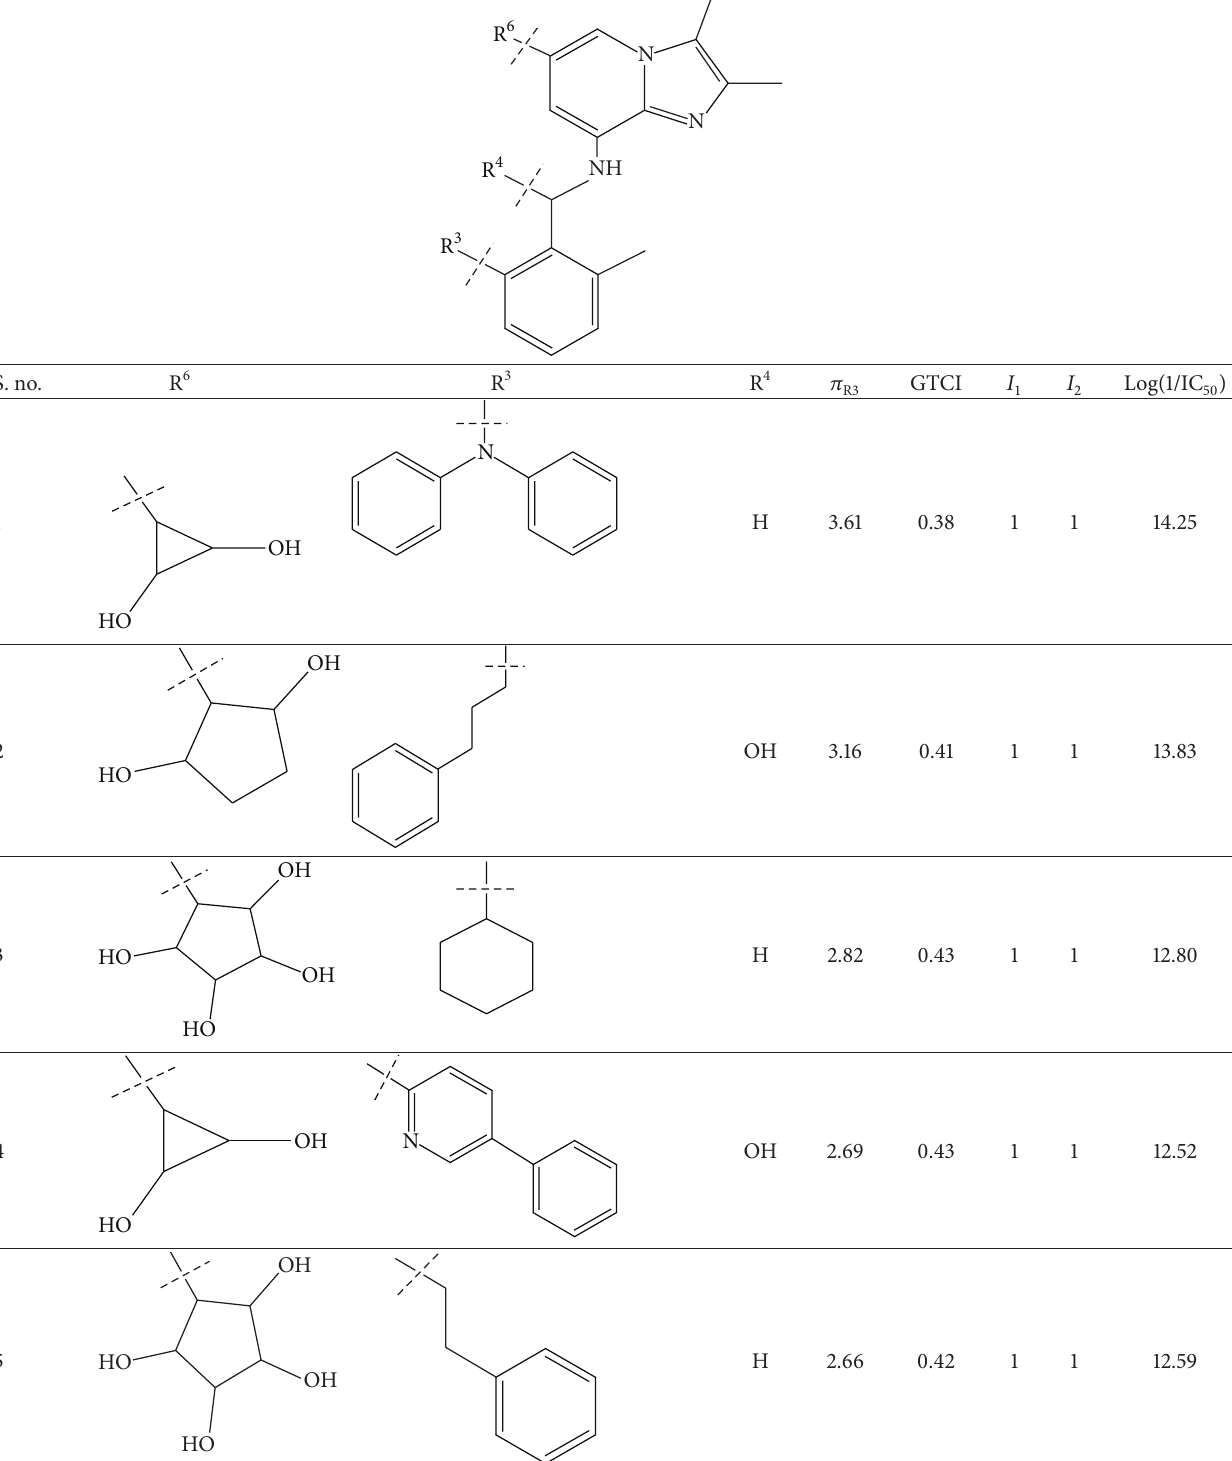
Table 2: Some proposed compounds belonging to the series of Table 1 and their activities predicted from (1).